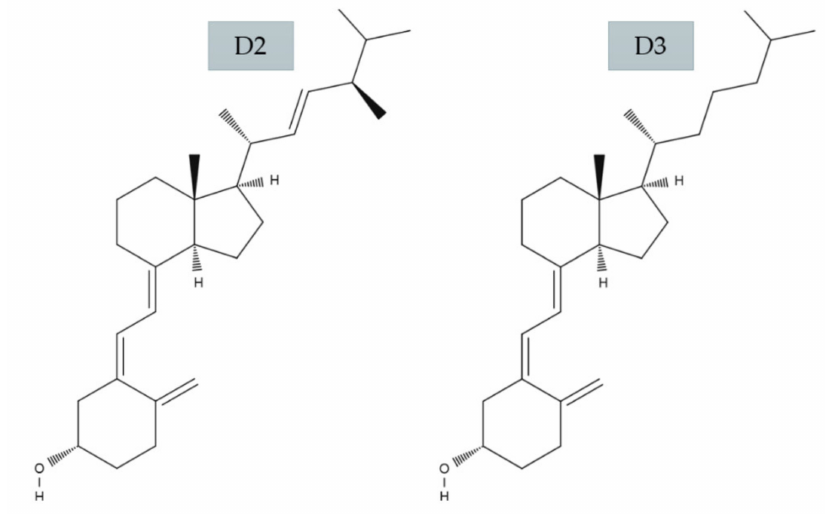
Figure 2. Molecular structure of vitamin D2 and D3 (based on Holick 2018 [38])